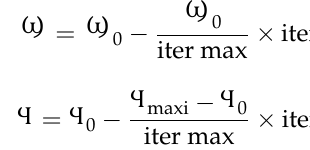
Figure 3. The overall architecture of the dynamic UAV approach.